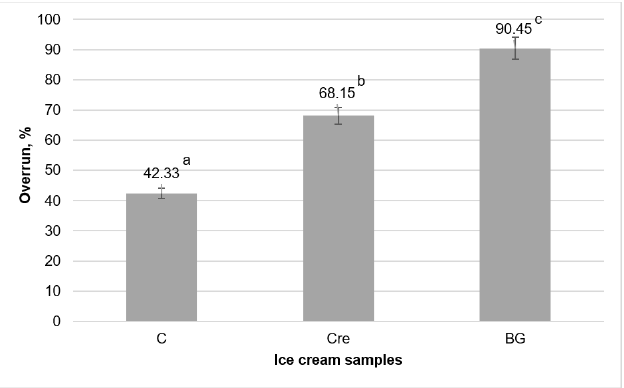
Figure 1. The overrun in soft ice cream: C is low-fat milky ice cream without stabilizer (control); Cre is low-fat milky ice cream with 0.5% of Cremodan ® SI 320; BG is low-fat milky ice cream with 0.5% of oat β -glucan; a–c mean values denoted by different letters in the column differ significantly at p ≤